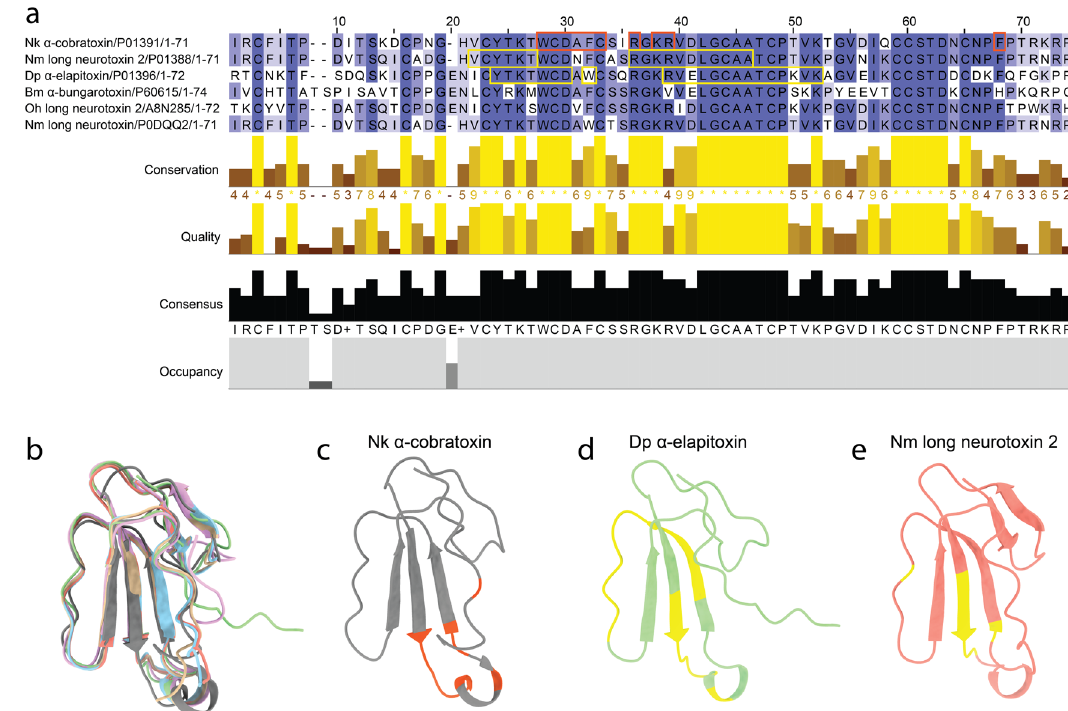
Fig. 3 | Alignment and epitope identi fi cation of all investigated long-chain α - neurotoxins, i.e., α -cobratoxin (P01391/1CTX) from N. kaouthia , α -elapitoxin (P01396/AF-P01396)from D.polylepis , α -bungarotoxin(P60615/1HC9) from B. multicinctus , long neurotoxin 2 (A8N285/AF-A8N285) from O. hannah , and long neurotoxin (P0DQQ2), long neurotoxin 4 from N. naja (P25672/AF- P25672), and long neurotoxin 2 (P01388/AF-P01388) from N. melanoleuca . a SequencealignmentusingClustalOmegawithboxesindicatingresiduesinvolved in binding to the nicotinicacetylcholine receptor (orange) or bound by antivenom antibodies (yellow). b Structural alignment in ChimeraX with the following colors